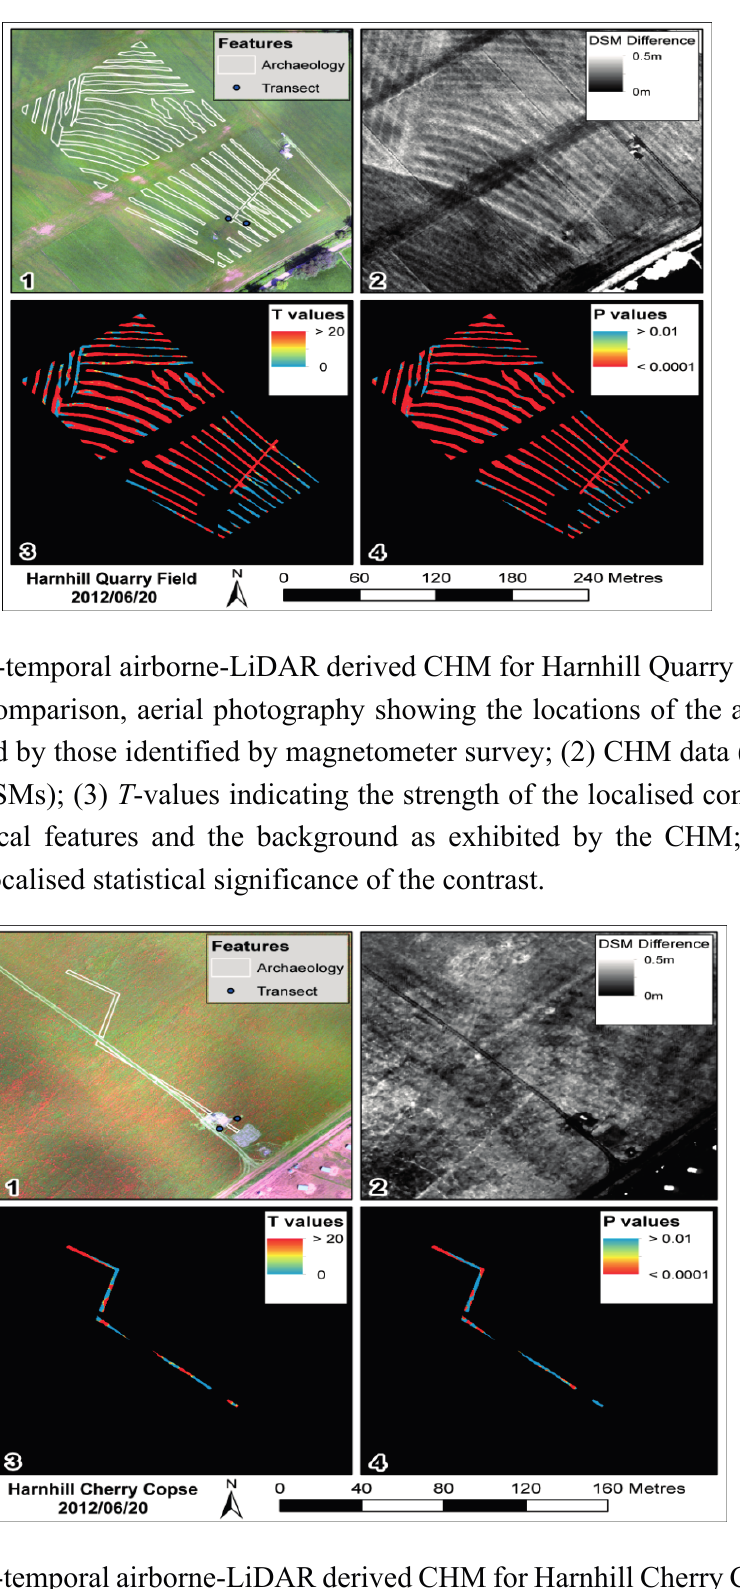
Figure 7. Multi-temporal airborne-LiDAR derived CHM for Harnhill Cherry Copse for June 2012. (1) For comparison, aerial photography showing the locations of the archaeological features overlaid by those identified by magnetometer survey; (2) CHM data (referred to as difference in DSMs); (3) T -values indicating the strength of the localised contrast between the archaeological features and the background as exhibited by the CHM; (4) P -values indicating the localised statistical significance of the